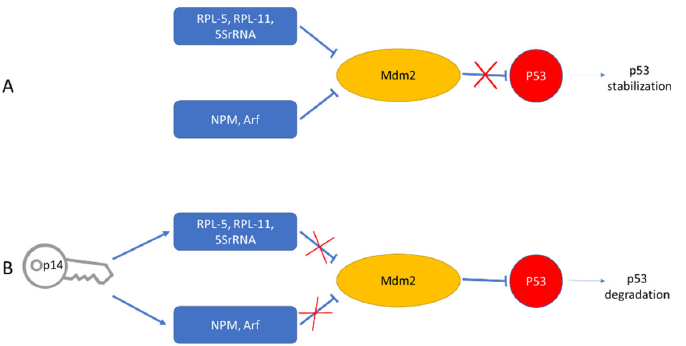
Figure 7. Model illustrating a proposed effect of p14 on p53 checkpoint. ( A ) In the absence of p14, MDM2 is inactivated by the NPM (B23) and RPL5 complexes, thus stabilizing p53. ( B ) In the presence of p14, the two complexes become inactive. In this case, p53 is degraded.